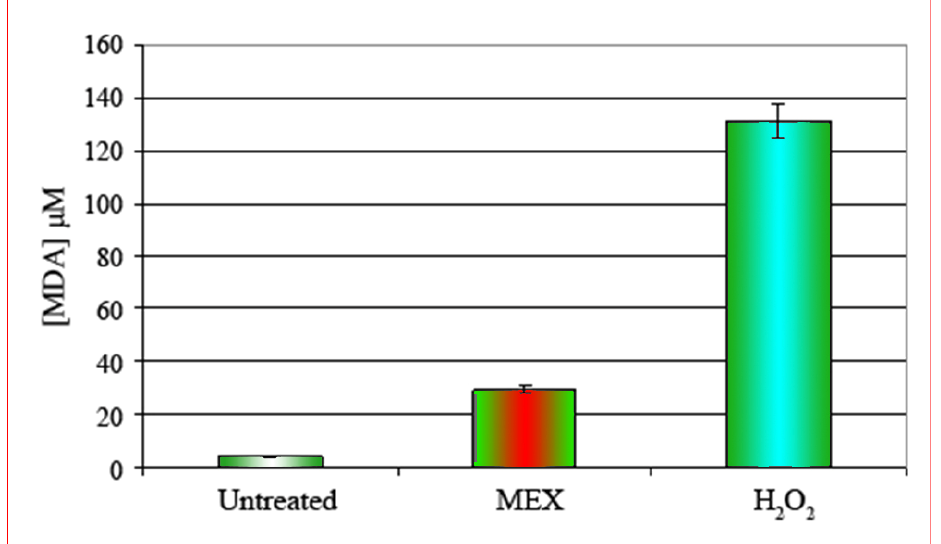
Figure 3. Concentration of malonaldialdehyde [MDA, μ M] after treatment with MEX (central bar). MDA concentration is about 25-fold higher as compared to untreated controls (left bar). The effect of treatment with H the standard error of the (mean ±